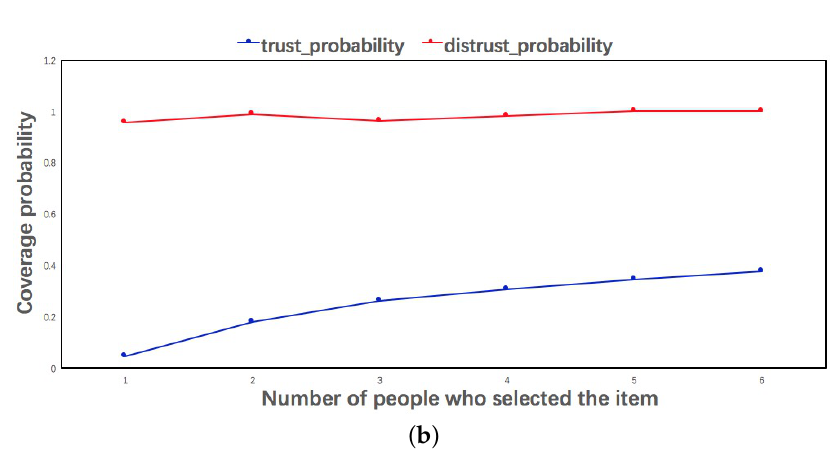
Figure 1. Preference Analysis: ( a ) coverage probability analysis; and ( b ) influence of social relations on selection